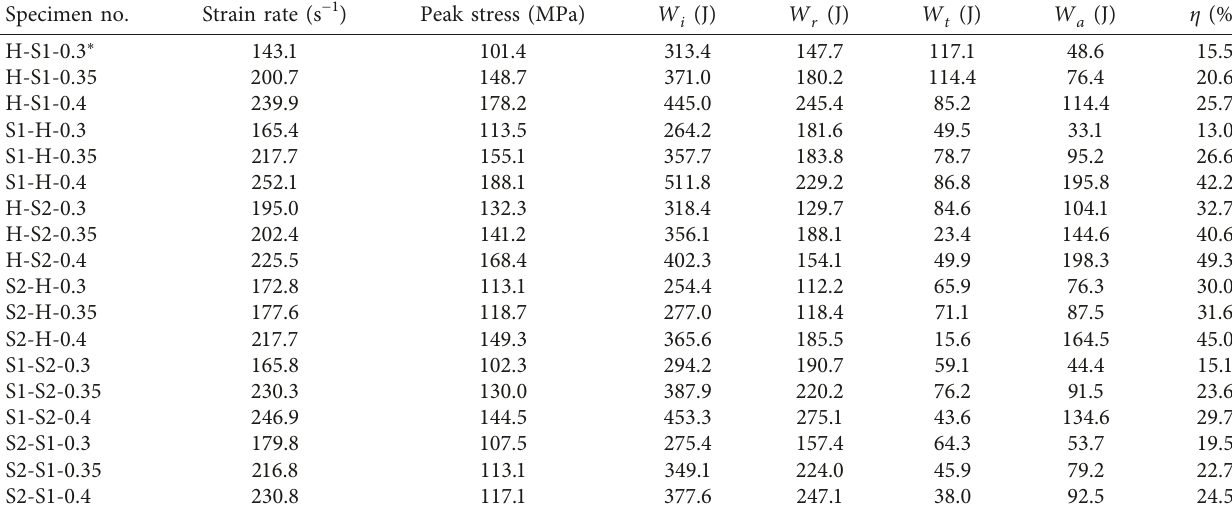
Table 2: Dynamic mechanical parameters of composite specimens for SHPB